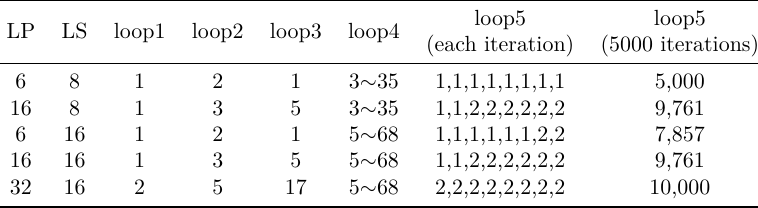
Table 1: Number of rounds in each loop for different LP and LS with 5000